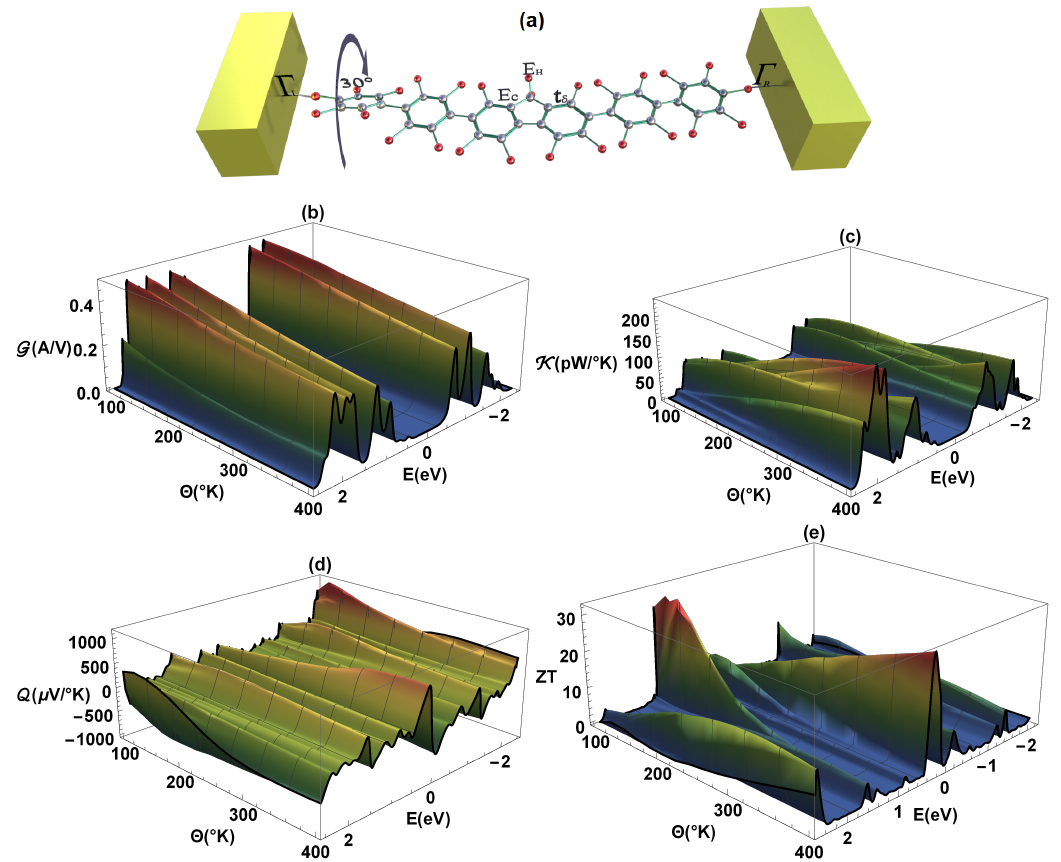
Figure 7. ( a ) Representation of the left dihedral angle rotation (30 ◦ ), ( b ) electrical conductance ( G ), ( c ) thermal conductance ( κ ), ( d ) Seebeck coefficient ( Q ), and ( e ) ZT as a function of energy and temperature ( Θ